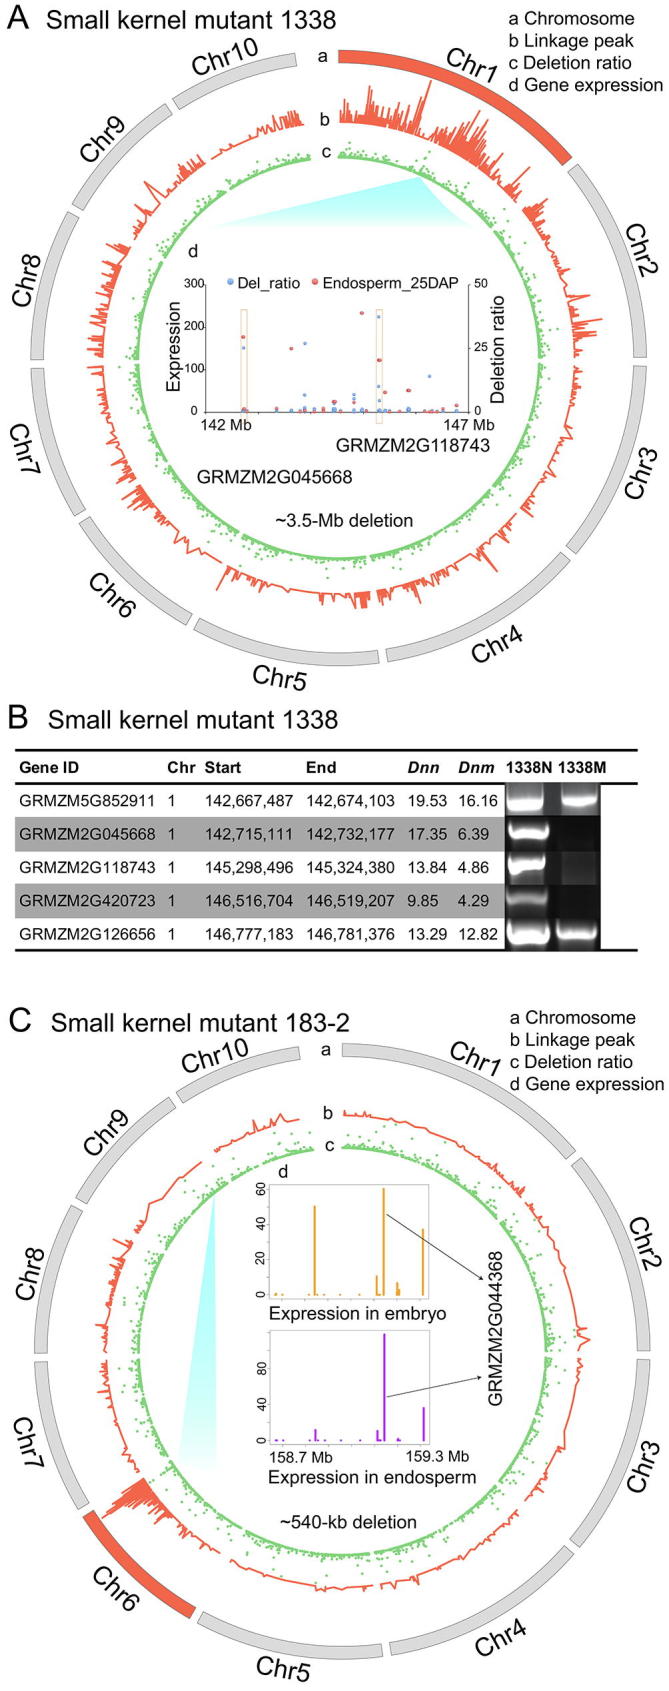
Causal gene search in mutants 1338 and 183-2 with small kernels A. Chromosomal plotting in mutant 1338. a, ten chromosomes in mutant 1338, with chromosome 1 in red for causal gene/deletion found; b, linkage peak (ranging from 0 to 16) in red; c, deletion ratio (ranging from 0 to 268) based on Dnn/(Dnm + 0.05) in a comparison of normal and mutant F2 pools in BSEx-seq; d, gene expression values (FPKM) of 25DAP in endosperm and deletion ratio of Dnn/(Dnm + 0.05) in the deletion are shown, and the genes (GRMZM2G118743 and GRMZM2G045668) with higher values are the likely candidate genes. B. Genomic PCR analysis shows that three genes (GRMZM2G045668, GRMZM2G118743, and GRMZM2G420723) were deleted in the deletion region in mutant 1338, whereas the two neighbor genes (GRMZM5G852911 and GRMZM2G126656) were not deleted. Dnn and Dnm indicate the normalized BSEx-seq read depth for normal and mutant samples, respectively. C. Chromosomal plotting in mutant 183-2. a, ten chromosomes in mutant 183-2, with chromosome 6 in red for causal gene/deletion found; b, linkage peak (ranging from 0 to 25) in red; c, deletion ratio (ranging from 0 to 210) based on Dnn/(Dnm + 0.05) in a comparison of normal and mutant F2 samples using BSEx-seq; d, gene expression values (FPKM) of 25DAP in endosperm and embryo in the deletion are shown, and the gene (GRMZM2G044368) with higher expression is the likely candidate gene.